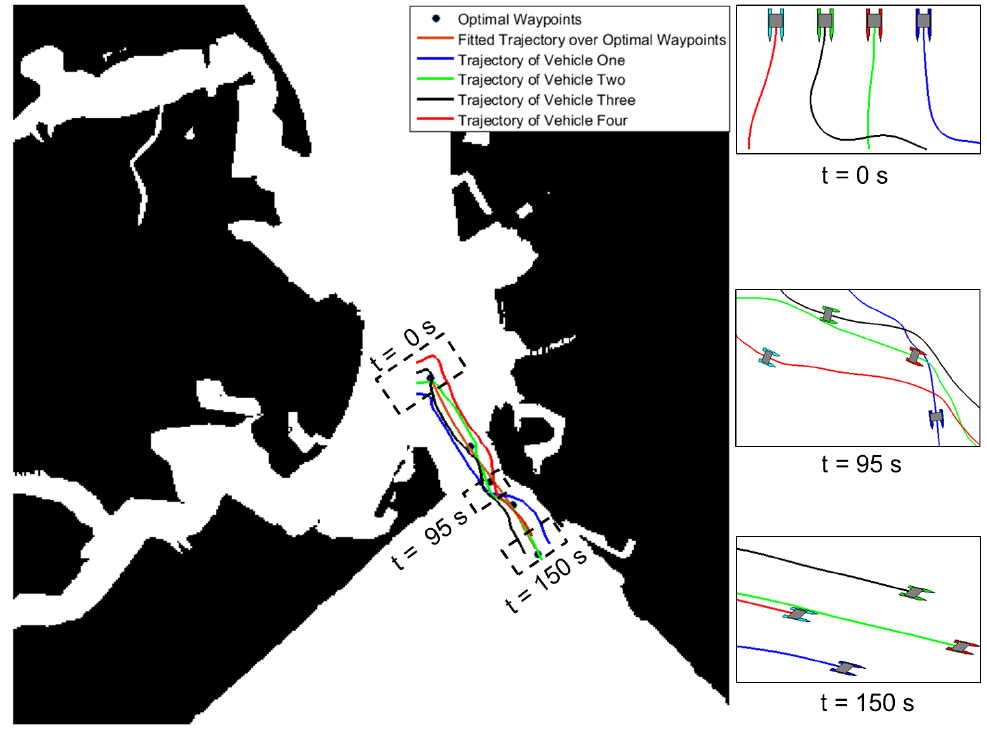
Figure 15. USV motions during swarm aggregation combined with path-following guidance for four